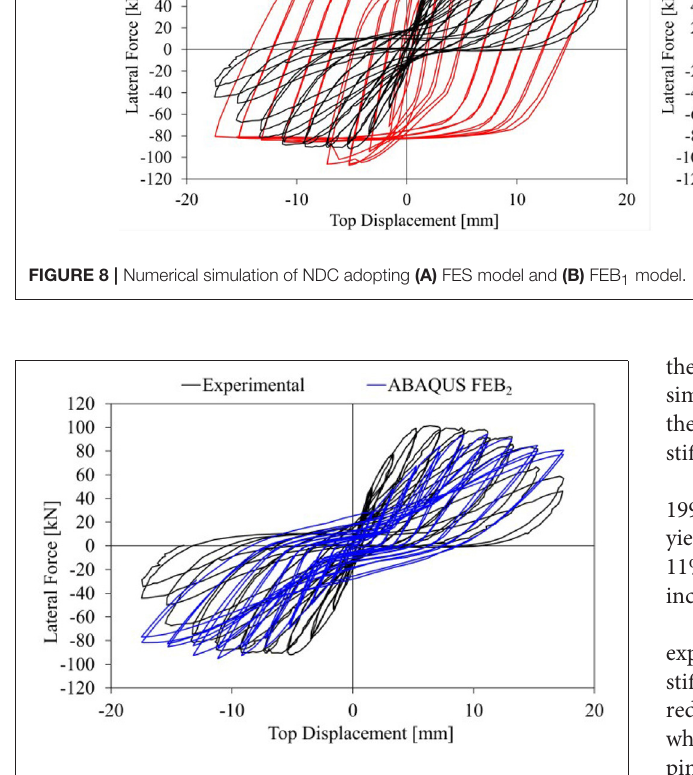
FIGURE 9 | Numerical simulation of NDC adopting FEB 2 model.